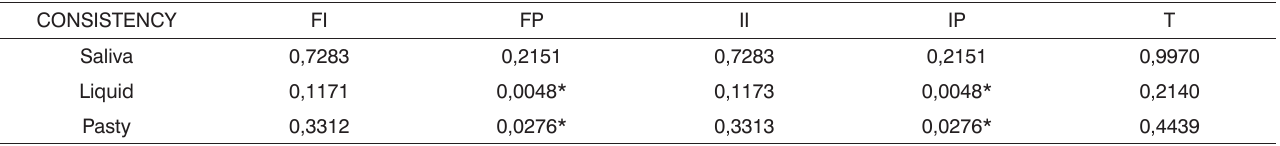
Table 8. Significance for each consistency for the three ages studied (males). CONSISTENCY